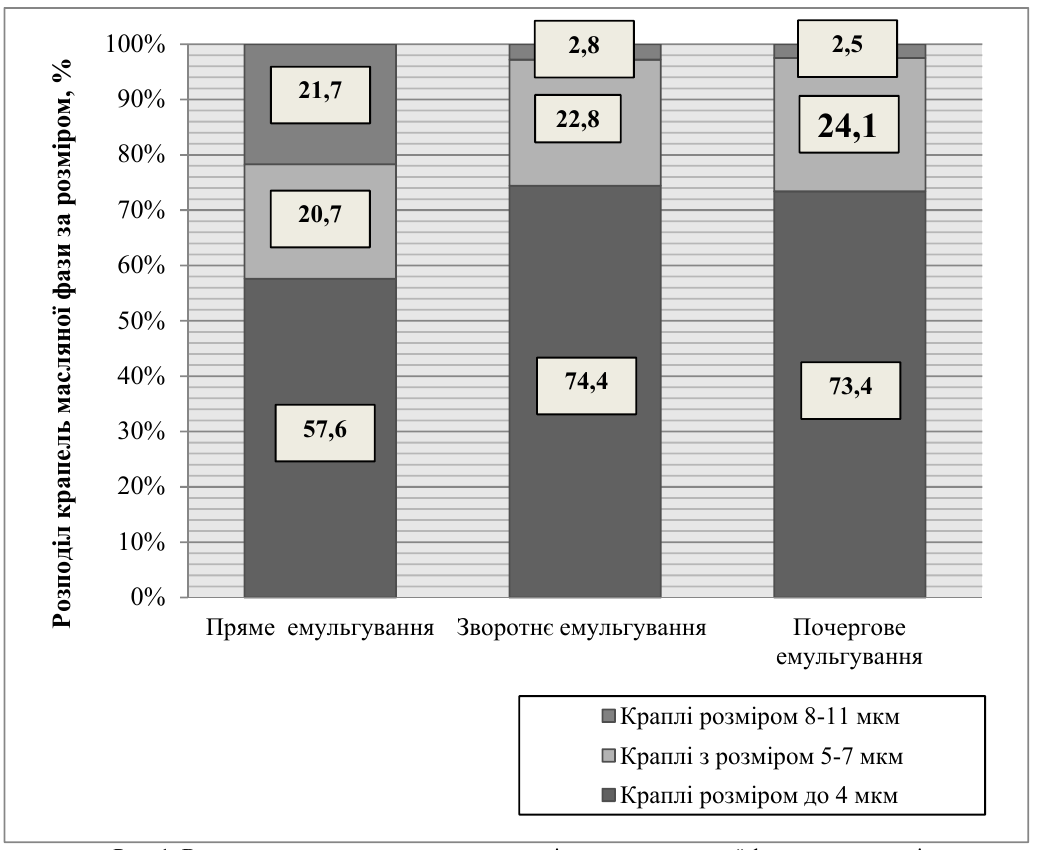
Рис . 1. Вплив методу емульгування на розподіл крапель масляної фази в крем -